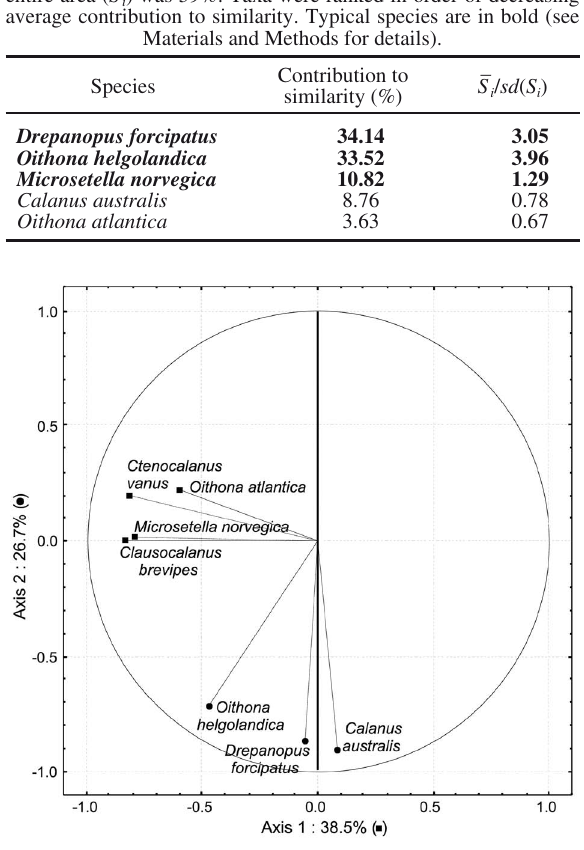
Fig. 4. – Principal component analysis (PCA) based on the cor- relation matrix. Representations on the ordination space of the correlations of species (variables) with the Axes 1 and 2 (circle of correlation).